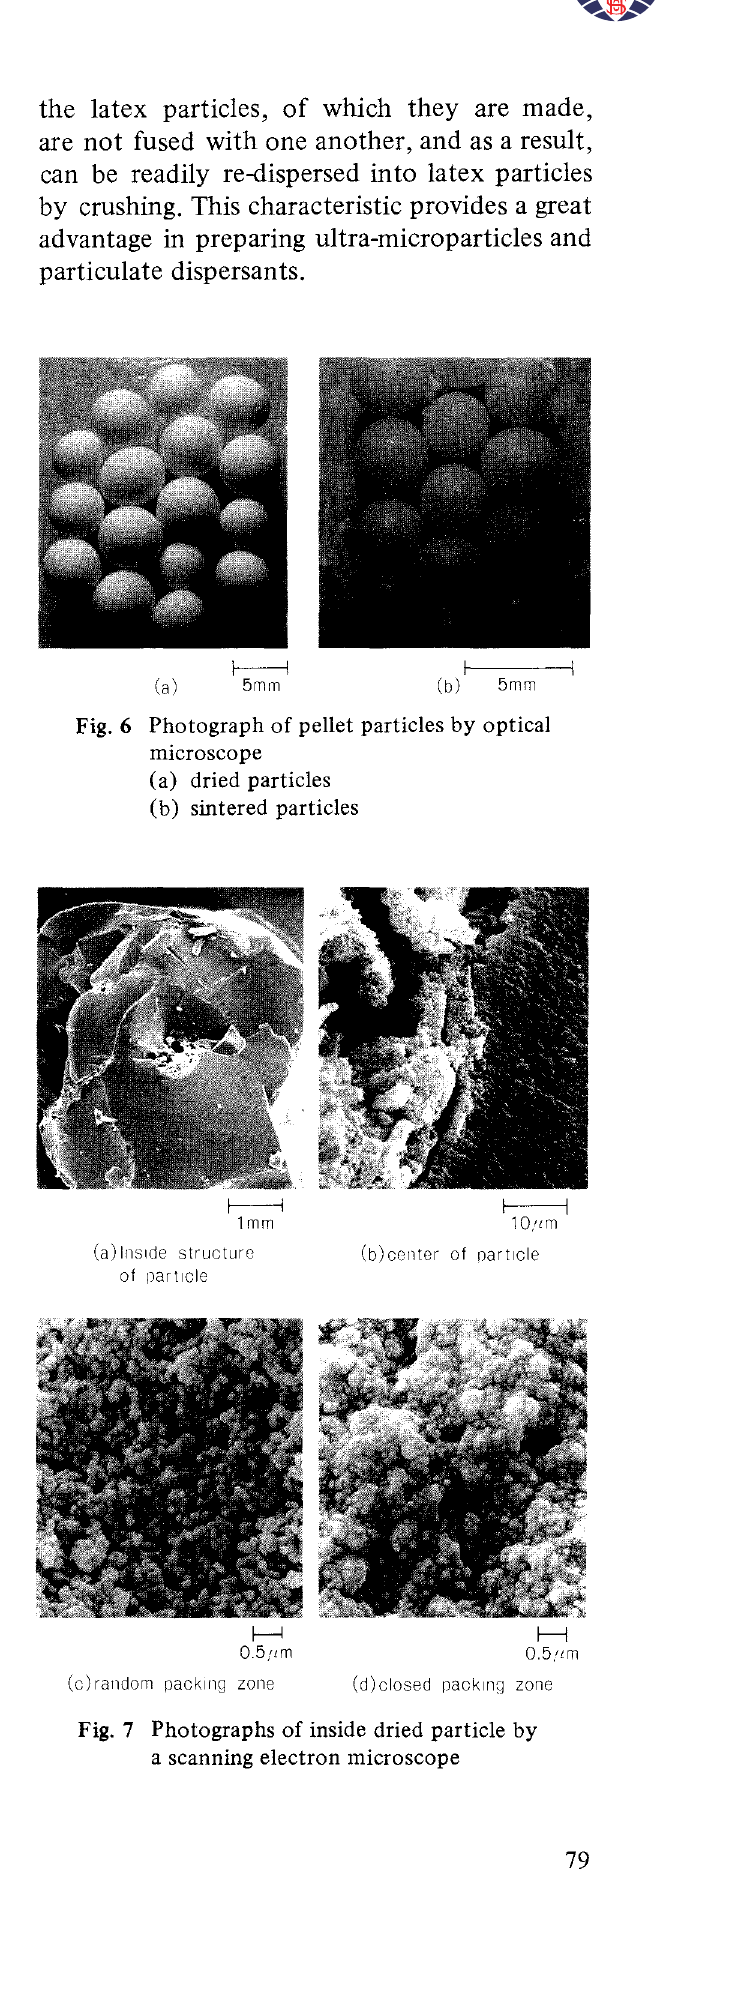
Fig. 7 Photographs of inside dried particle by a scanning electron